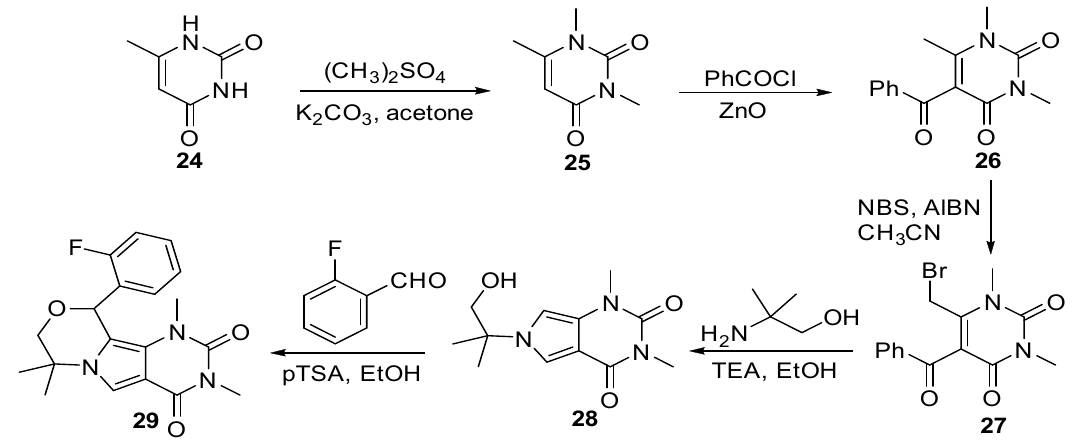
Scheme 7. The synthesis of pyrimido-pyrrolo-quinoxalinedione for inhibiting nucleoprotein of in-